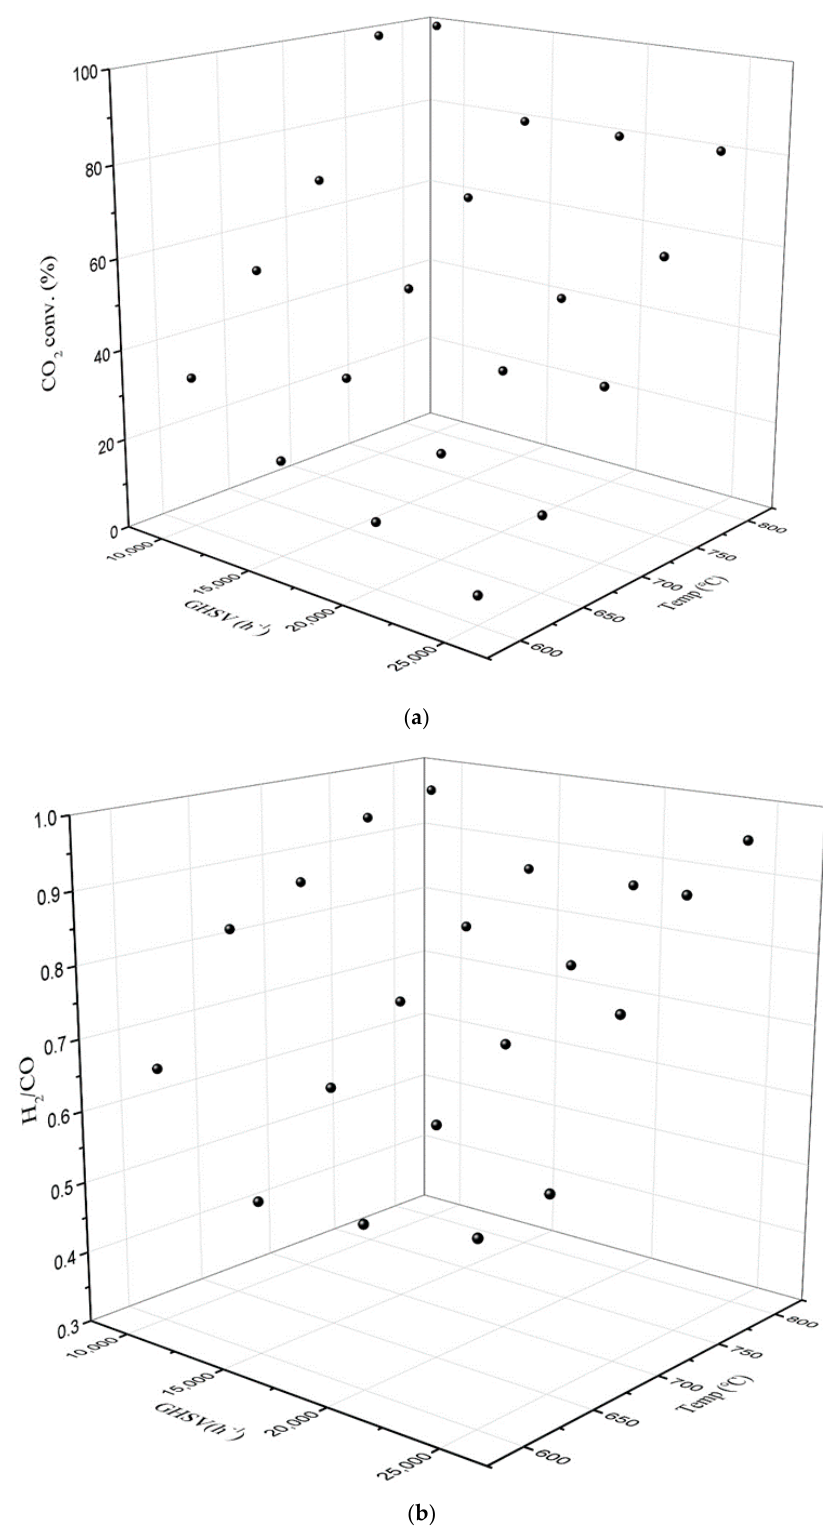
Figure 12. The effect of temperature and GHSV on ( a ) the CH 4 conversion and ( b ) H 2 /CO ratio in the DRM at the pressure of 1 bar and feed molar ratio of CH 4 :CO 2 = 1 over NZTA (2) catalyst.